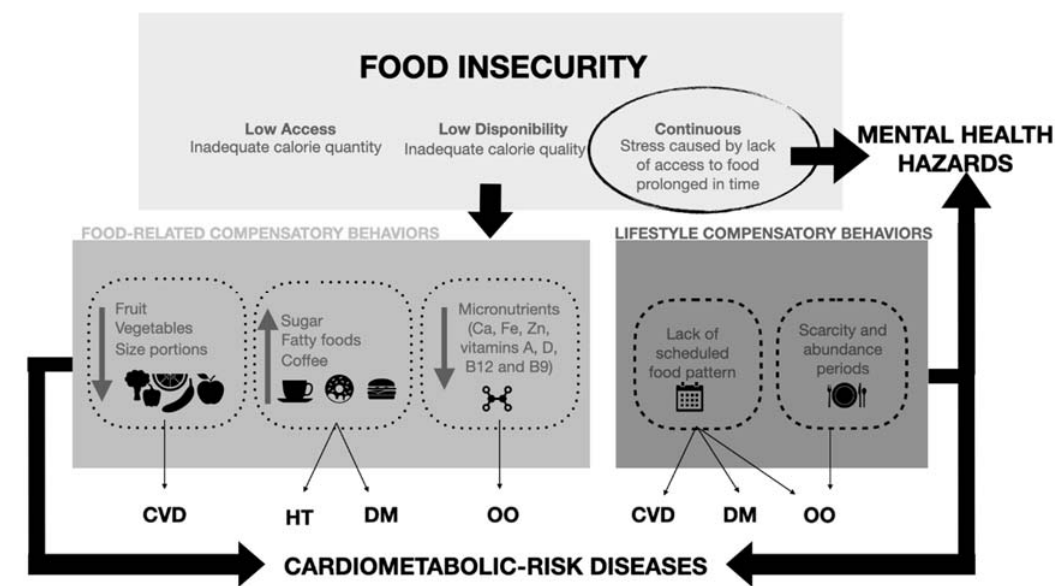
Figure 2. Conceptual framework showing the relationship between eating behavior and cardiometabolic risk ‐ related diseases and mental wellness in food insecurity context. Abbreviations; CVD: cardiovascular disease, HT: hypertension, DM: diabetes mellitus, and OO: overweight and obesity .